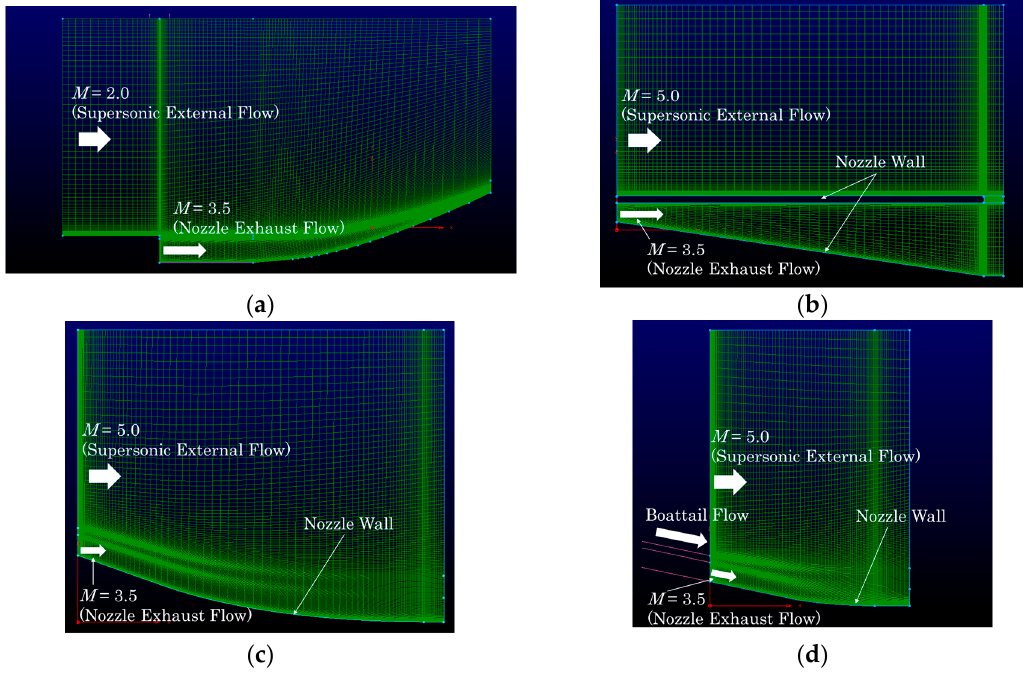
Figure 8. Mesh grids used for calculation of the aftbody flowfield. The flow direction is from left to right. The region of interest for computation is the area indicated by the grid. ( a ) For validation with experiment; ( b ) Case 1; ( c ) Case 3; ( d ) Case 4.